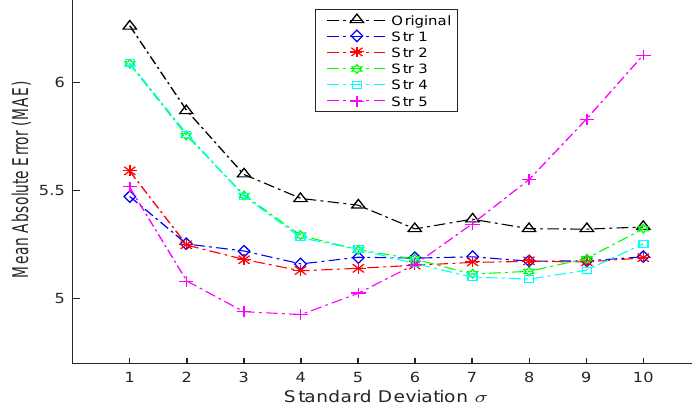
Figure 5. The line chart (variation tendency) of MAEs with respect to different standard deviations for the original LDL algorithm and the proposed SDM-LDL algorithms with different strategies when age label distribution is generated as Gaussian-like